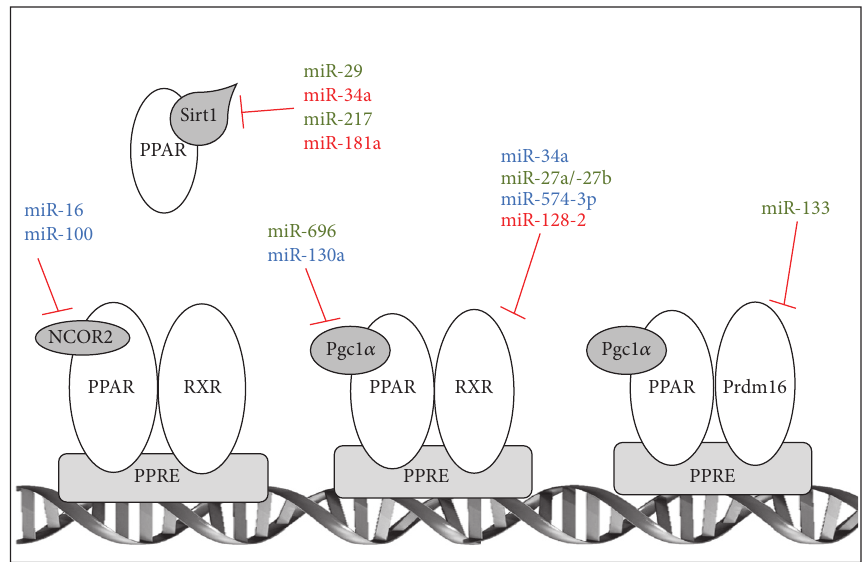
Figure 3: miRNAs targeting PPAR transcriptional partners, cofactors/repressors, and other regulators. miRNAs that have been experi- mentally demonstrated to specifically target PPAR transcriptional partners (RXR and Prdm16), PPAR cofactors (Pgc1 𝛼 ), PPAR repressors (NCOR2), and other PPAR regulators (Sirt1) are illustrated. miRNAs identified in human studies are in blue, those identified in mouse/rat studies are in green, and those identified in both human and rodents studies are in red. PPAR: peroxisome proliferator-activated receptor 𝛼 , 𝛽 / 𝛿 , or 𝛾 ; RXR: Retinoid-X-Receptor; Prdm16: PR domain-containing 16; Sirt1: Sirtuin-1; NCOR2: nuclear receptor corepressor 2 (SMRT); Pgc1 𝛼 : peroxisome proliferator-activated receptor gamma coactivator 1; PPRE: peroxisome proliferator response element